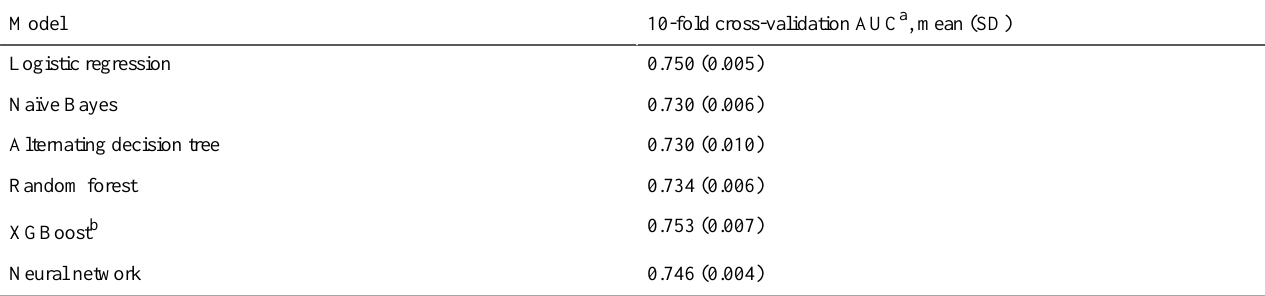
Table 3. 10-fold cross-validation AUCs of the candidate models on the development set.